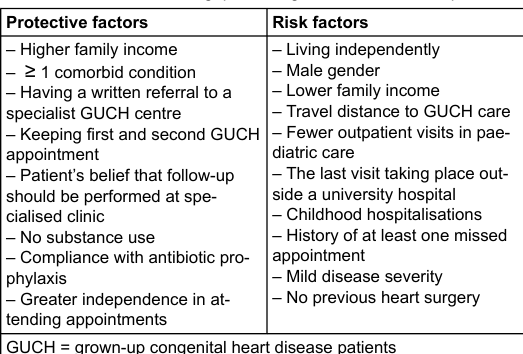
Table 3: Predictors of care gaps in congenital heart disease patients.